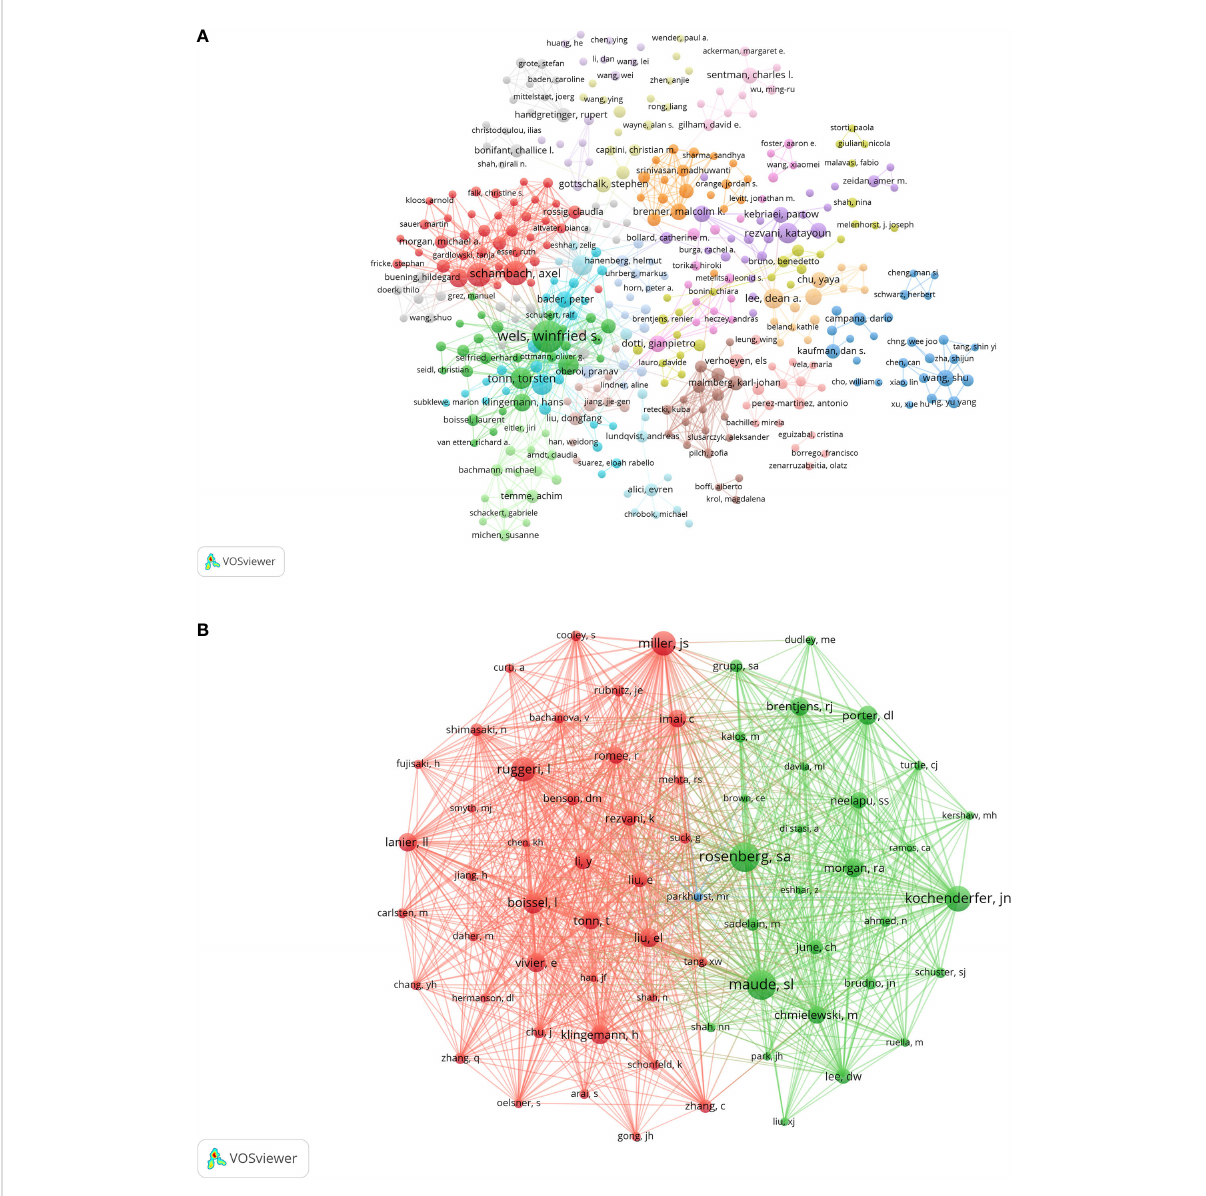
FIGURE 5 The visualization map of authors (A) co-cited authors (B) involved in CAR-NK cells. Minimum number of documents of an aduthor ≥ 2; Note: Minimum number of citations of an aduthor ≥